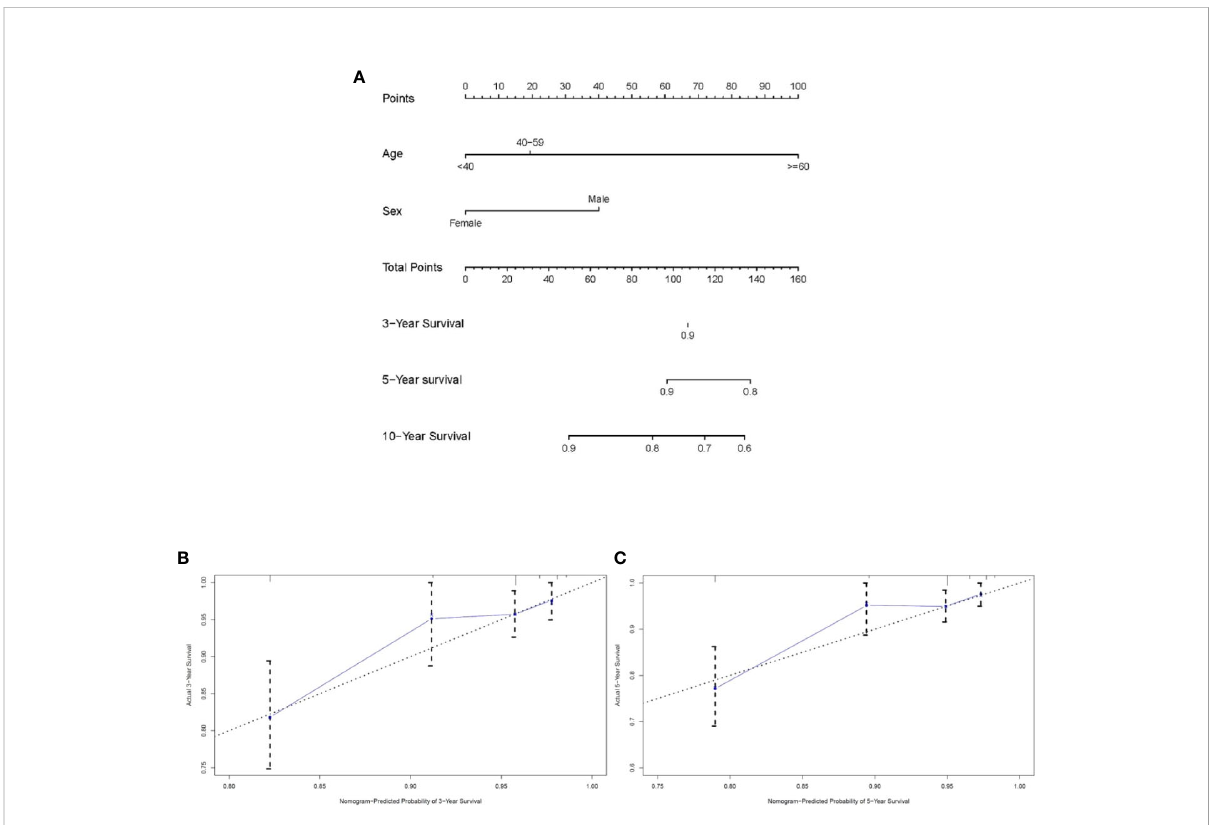
FIGURE 3 Nomogram analyses for patients with intracranial subependymoma. (A) A nomogram for predicting 3-, 5- and 10-year OS of patients. (B) Calibration curve of the nomogram predicting 3-year OS in training cohort. (C) Calibration curve of the nomogram predicting 5-year OS in training cohort. OS, overall